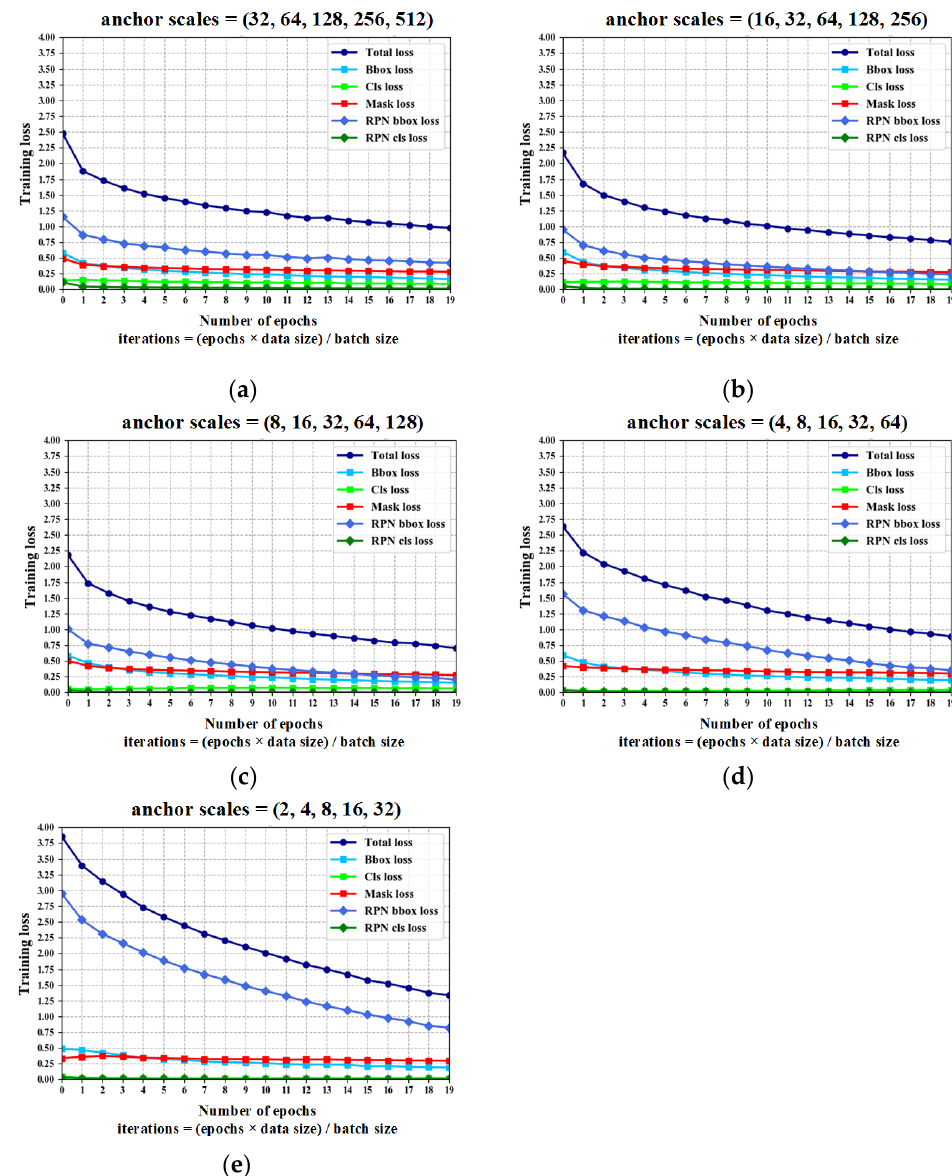
Figure 7. Network convergence curves at different anchor scales: ( a ) anchor scales = (32, 64, 128, 256, 512) (baseline); ( b ) anchor scales = (16, 32, 64, 128, 256) (one half of the baseline); ( c ) anchor scales = (8, 16, 32, 64, 128) (a quarter of the baseline); ( d ) anchor scales = (4, 8, 16, 32, 64) (one-eighth of the baseline); and ( e ) anchor scales = (2, 4, 8, 16, 32) (one-sixteenth of the baseline). Table 2. Loss comparison of the network models under different anchor scales.